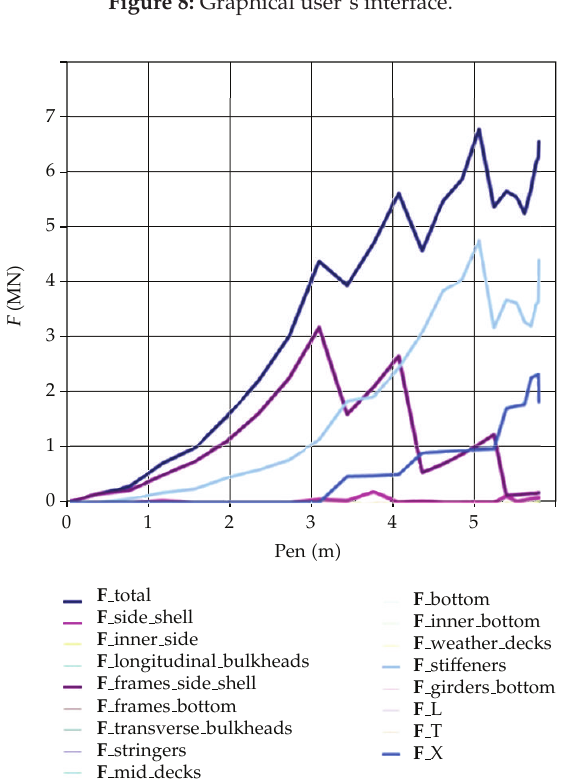
Figure 9: Example of substructures crushing forces